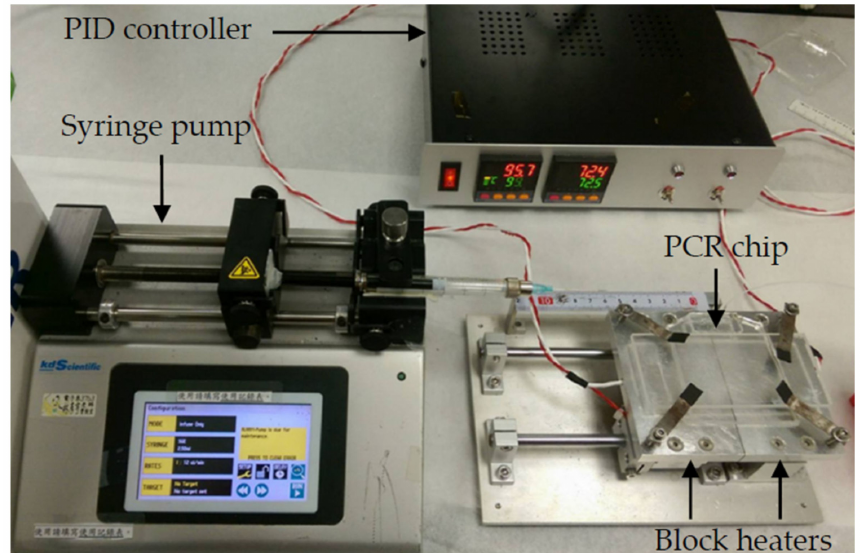
Figure 2. Experimental setup of ultrafast PCR platform. The block heaters at the bottom of the chip use a polyimide film heater for heating and a PT100 temperature sensor for measuring the temperature. The temperature is controlled via PID feedback, and the sample is injected into the chip via the syringe